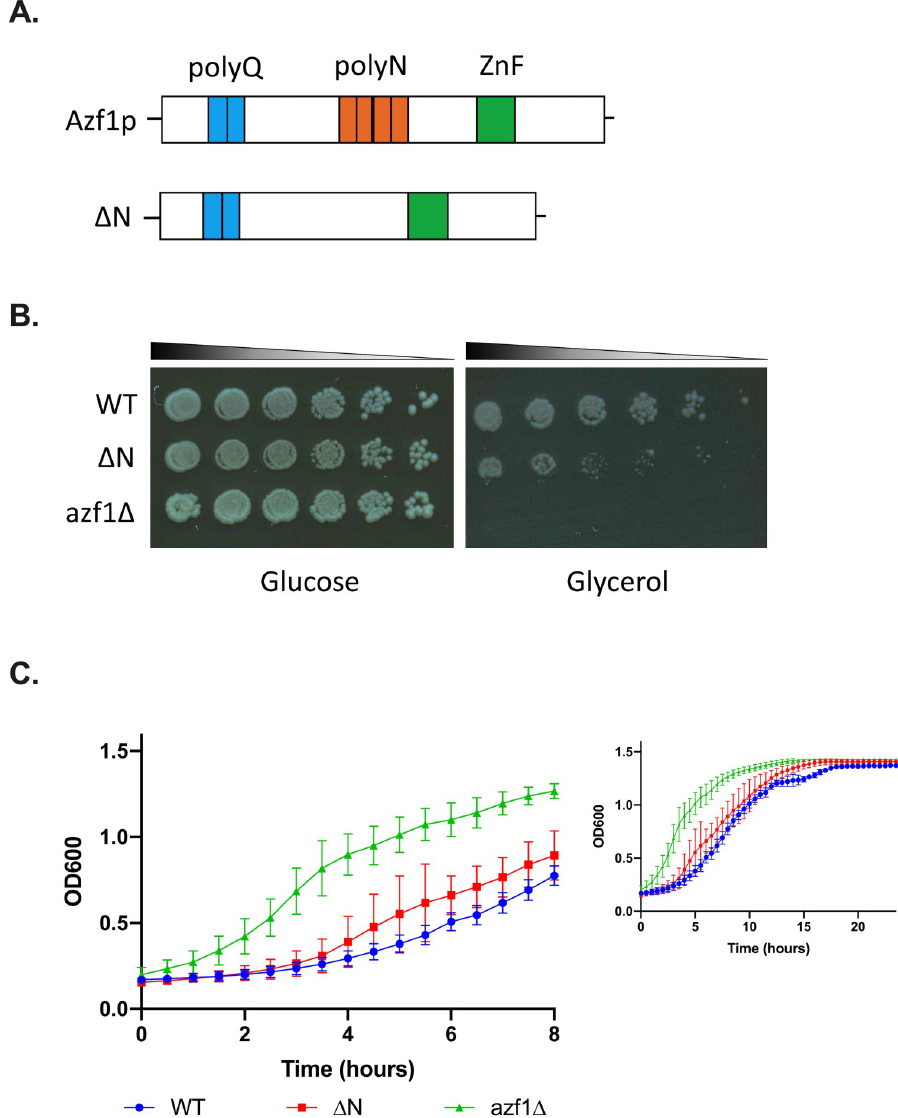
Fig 2. The polyN domain of Azf1p impacts growth in different carbon sources. A) Schematic of WT and Δ N Azf1p. Azf1p contains a polyQ (teal), polyN (orange), and a zinc-finger DNA-binding domain (ZnF) (green). To probe the role of the polyN domain, we deleted this domain in AZF1-GFP [32,33].B) Spotting assay measuring the growth of WT, Δ N , and azf1 Δ on glucose and glycerol. On glycerol, deletion of the polyN domain produces a mild growth defect, while azf1 Δ produces a severe growth defect. Images are representative of 3 independent experiments. C) Growth of WT, Δ N, and azf1 Δ with glucose as the carbon source. Growth was measured by OD 600 in a plate reader for 24 hours. The first 8 hours are highlighted to show the differences in growth more clearly and due to the reduced accuracy of the plate reader at high optical densities. Deletion of the polyN domain moderately shortens the lag phase, and azf1 Δ dramatically shortens the lag phase compared to WT. Growth curves are the average of three biological replicates, and error bars indicate standard deviation.